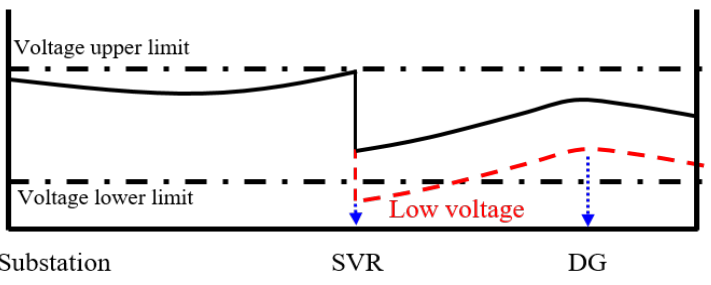
Figure 5. Voltage Profiles under co-generation mode.